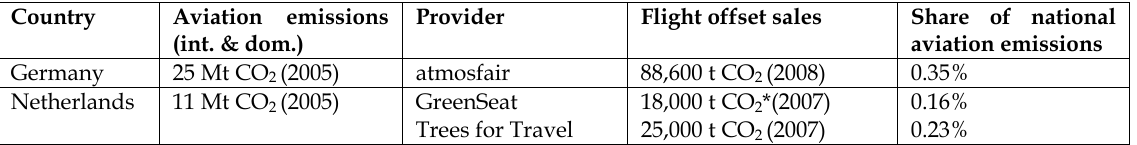
Table 1. Comparison of flight offset volumes with national aviation emissions Country Aviation emissions Provider Flight offset sales Share of national (int. & dom.) aviation emissions Germany 25 Mt CO 2 (2005) atmosfair 88,600 t CO 2 (2008) 0.35% 0.16% Netherlands 11 Mt CO 2 (2005) GreenSeat 18,000 t CO 2 *(2007) Trees for Travel 25,000 t CO 2 (2007)